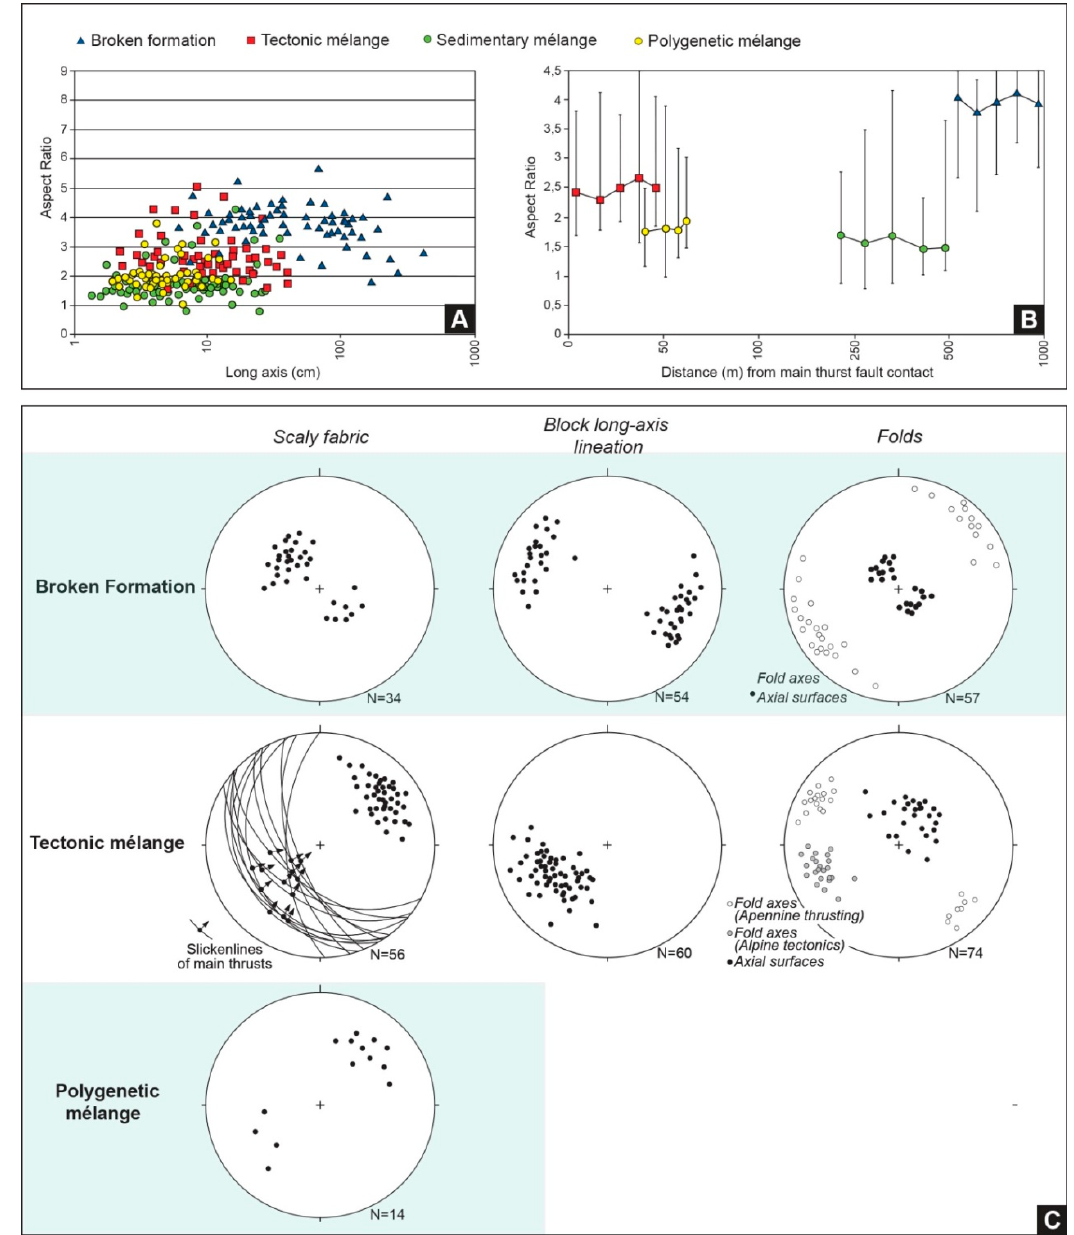
Figure 4. Diagrams showing block characteristics and rock fabric in different types of mélanges: ( A ) aspect ratio (block long axis / short axis) vs block long axis; ( B ) aspect ratio vs. location of chaotic units (i.e., distance from the thrust faults). Data are plotted as means with 95% error bars indicated; ( C ) mesoscale data (Schmidt net, lower hemisphere) of scaly fabric, lineation of the long axis of the blocks, and folds of broken formation, tectonic mélange, and polygenetic mélange.